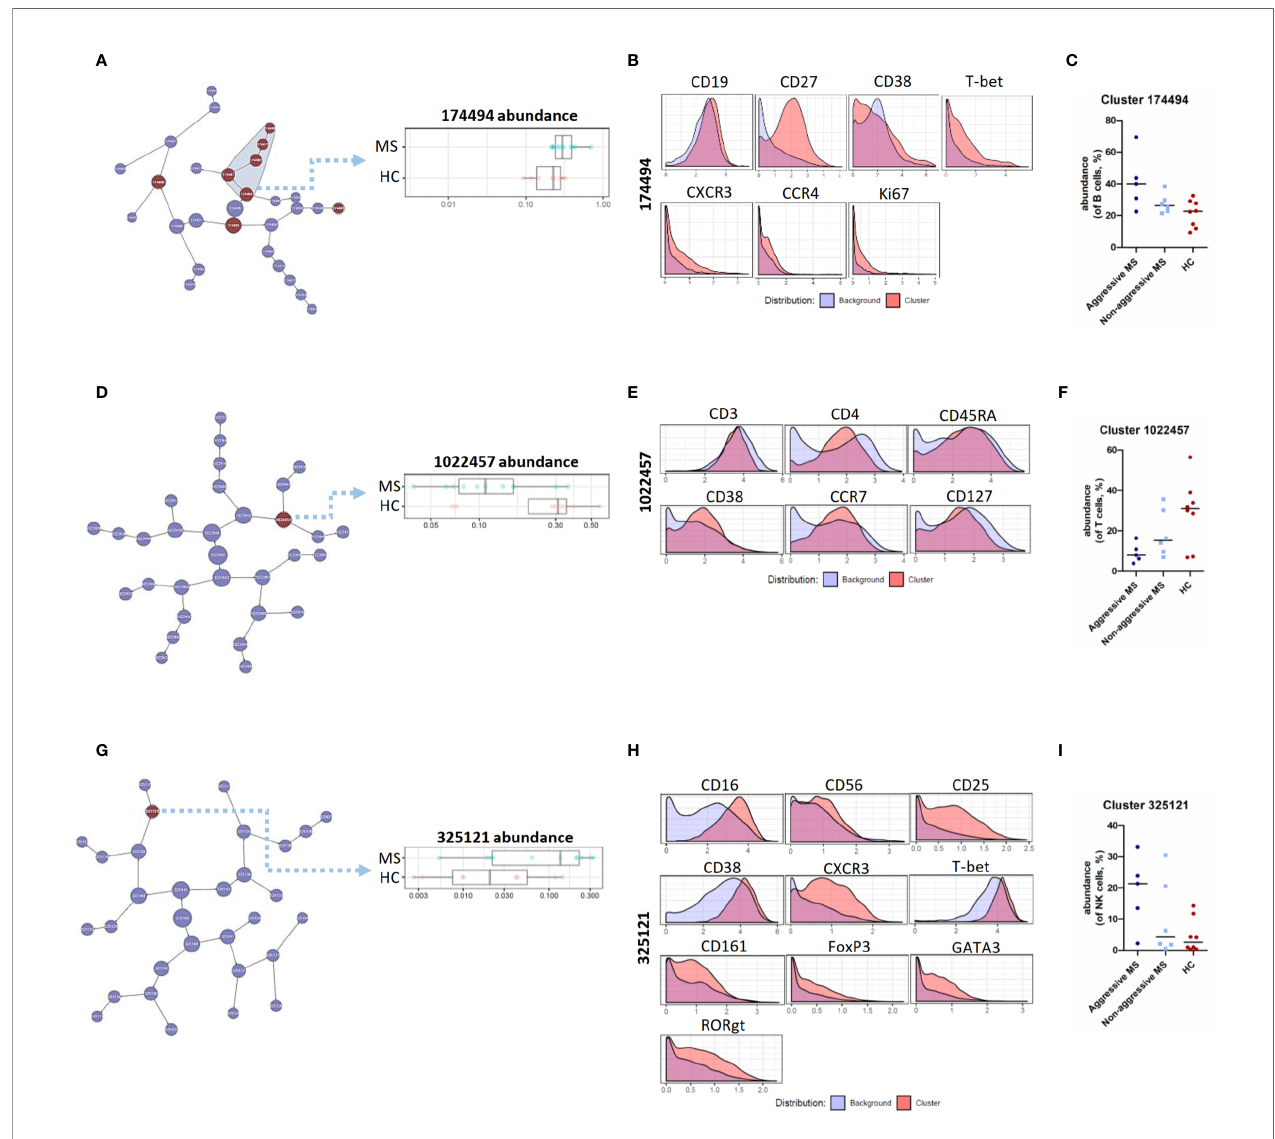
FIGURE 2 | CITRUS analysis of mass cytometry data from PBMC of MS patients and HC – B, T, NK cell lineages. (A) Visual representation of unsupervised hierarchical clustering of B cells and visualization of the clusters that are part of the signi fi cant results (in red). Abundance of the cluster 174494 (of B cells) in MS patients and HC. (B) Expression of CD19, CD27, CD38, T-bet, CXCR3, CCR4, and Ki67 on cells from cluster 174494 as compared to all other (background) B cells. (C) Abundance of cluster 174494 (of B cells, %) in « aggressive MS » patients, « non-aggressive MS » patients and HC. (D) Visual representation of unsupervised hierarchical clustering of T cells and visualization of the cluster that are part of the signi fi cant results (in red). Abundance of the cluster 1022457 (of T cells) in MS patients and HC. (E) Expression of CD3, CD4, CD45RA, CD38, CCR7, CD127 measured on cells from cluster 1022457 as compared to all other (background) T cells. (F) Abundance of cluster 1022457 (of T cells, %) in « aggressive MS » patients, « non-aggressive MS » patients and HC. (G) Visual representation of unsupervised hierarchical clustering of NK cells and visualization of the cluster that are part of the signi fi cant results (in red). Abundance of the cluster 325121 (of NK cells) in MS patients and HC. (H) Expression of CD16, CD56, CD25, CD38, CXCR3, T-bet, CD161, FoxP3, GATA3, and RORgt measured on cells from cluster 325121 as compared to all other (background) NK cells. (I) Abundance of cluster 325121 (of NK cells, %) in « aggressive MS » patients, « non-aggressive MS » patients and